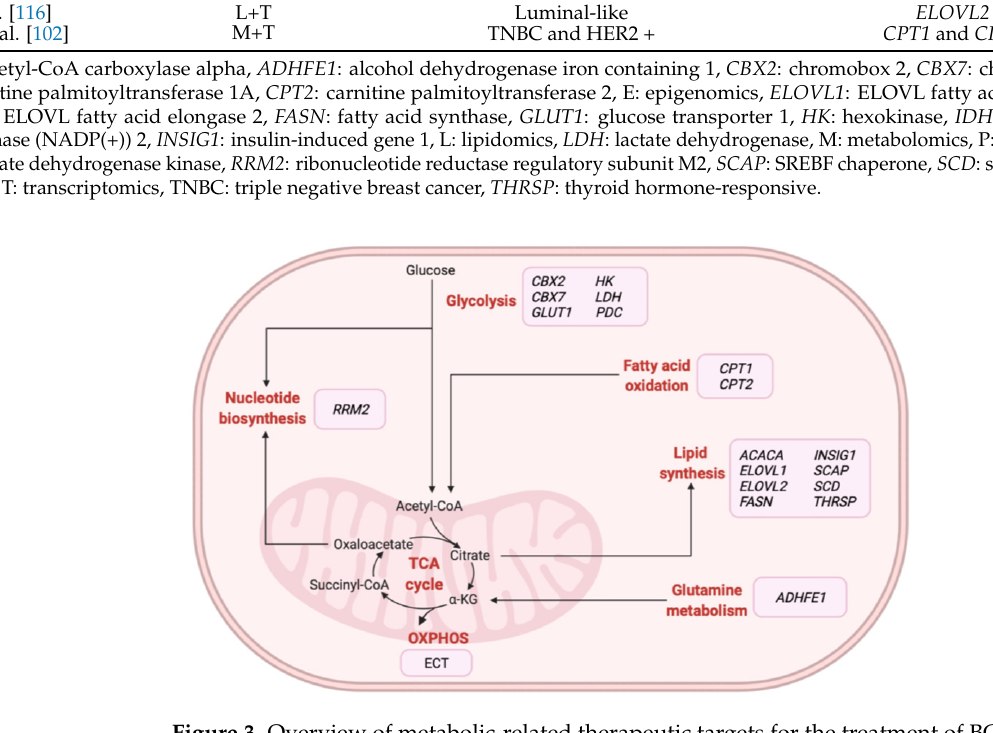
Figure 3. Overview of metabolic-related therapeutic targets for the treatment of BC patients identi-